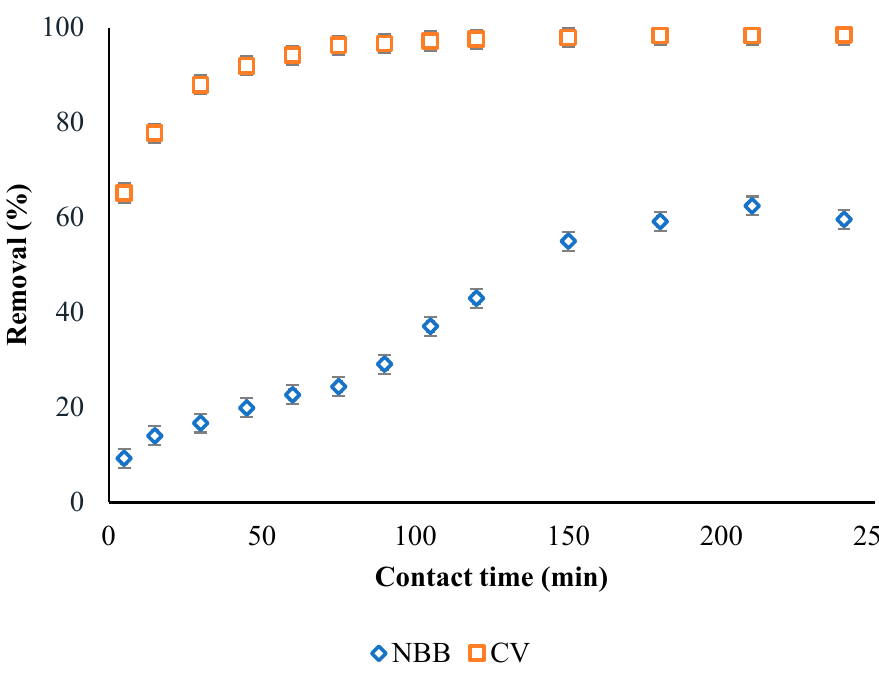
Figure 6. Effect of contact time on the removal of 100 mg L − 1 initial dye concentration of NBB and CV by 0.3 g L − 1 of ACOC.